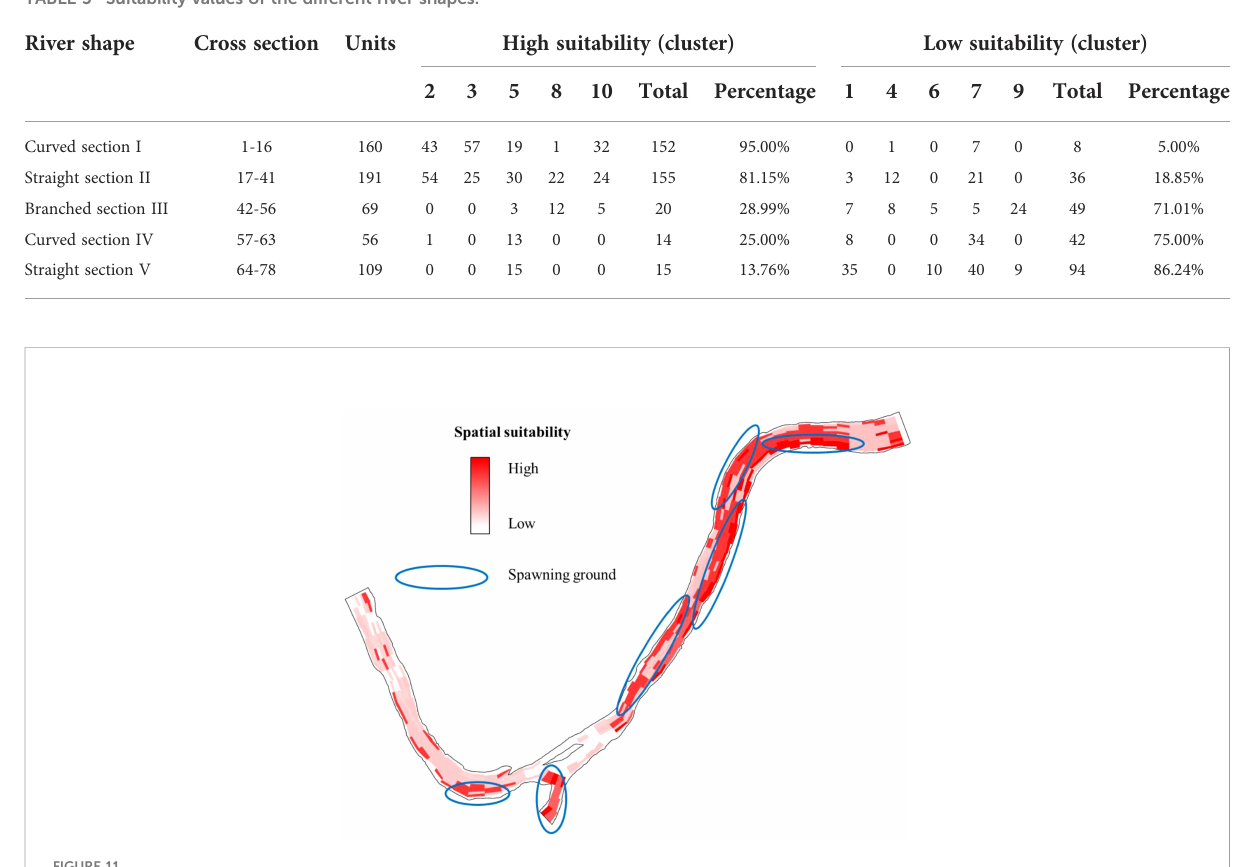
TABLE 5 Suitability values of the different river shapes.